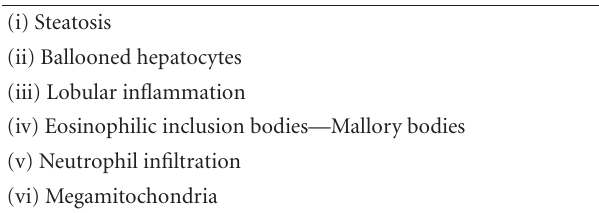
Table 1: Histological features in alcoholic hepatitis. Table 2: Patient demographics and histological findings in the 44 biopsy proven alcoholic hepatitis.